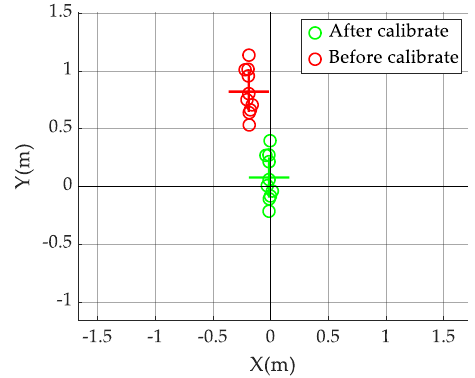
Figure 4. Comparison of the straight driving paths before and after wheel diameter error calibration.